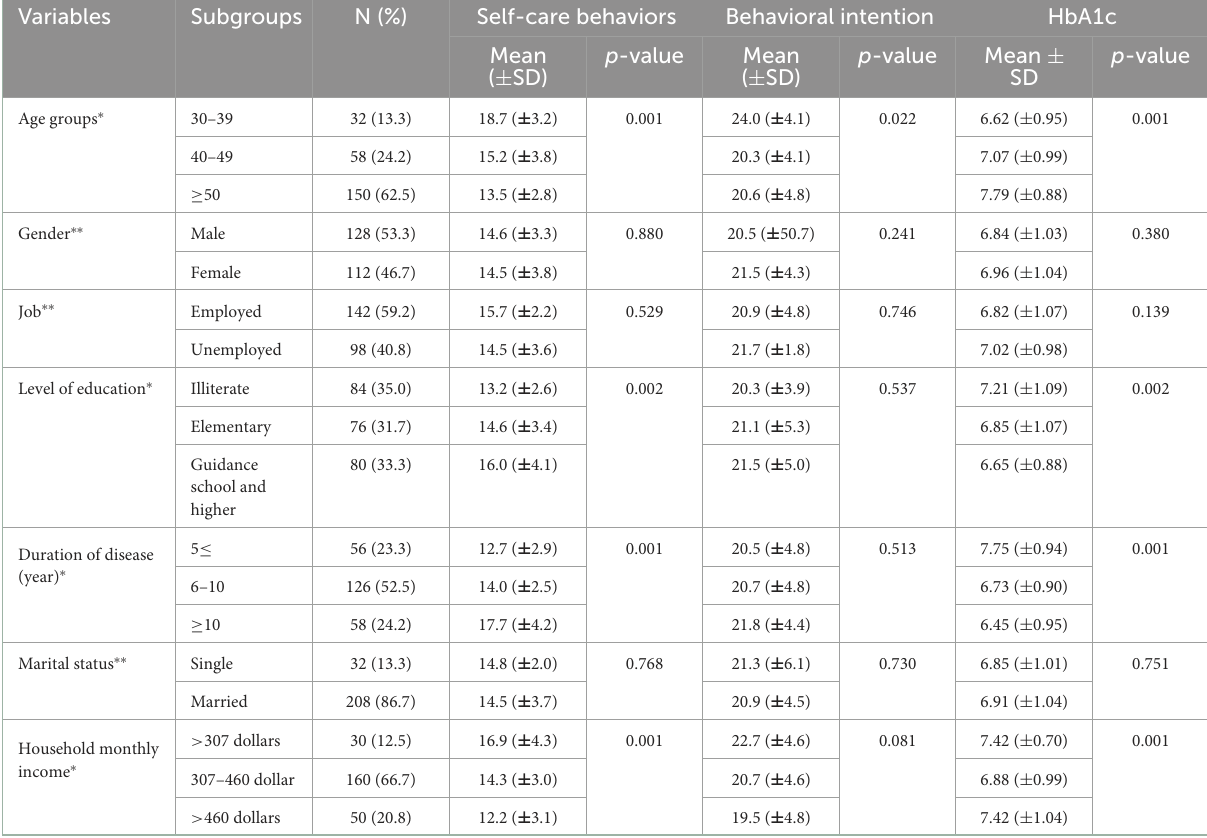
TABLE 1 Demographic characteristics and their associations with self-care behaviors among diabetic patients.